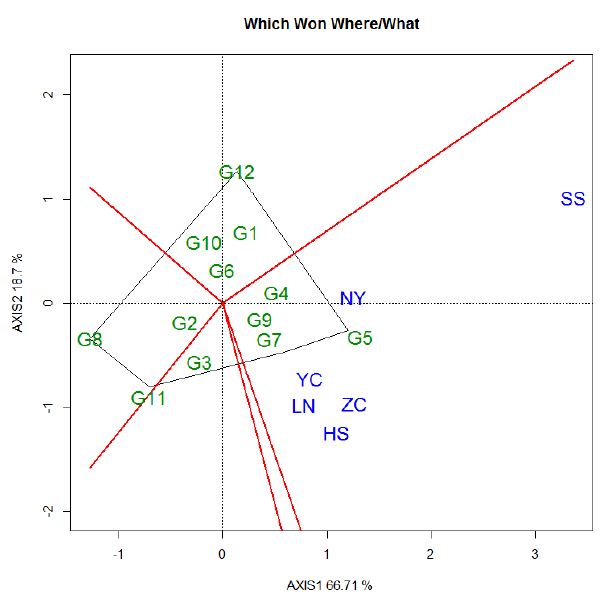
Figure 9. Biplot of “which won where” of tree DBH.